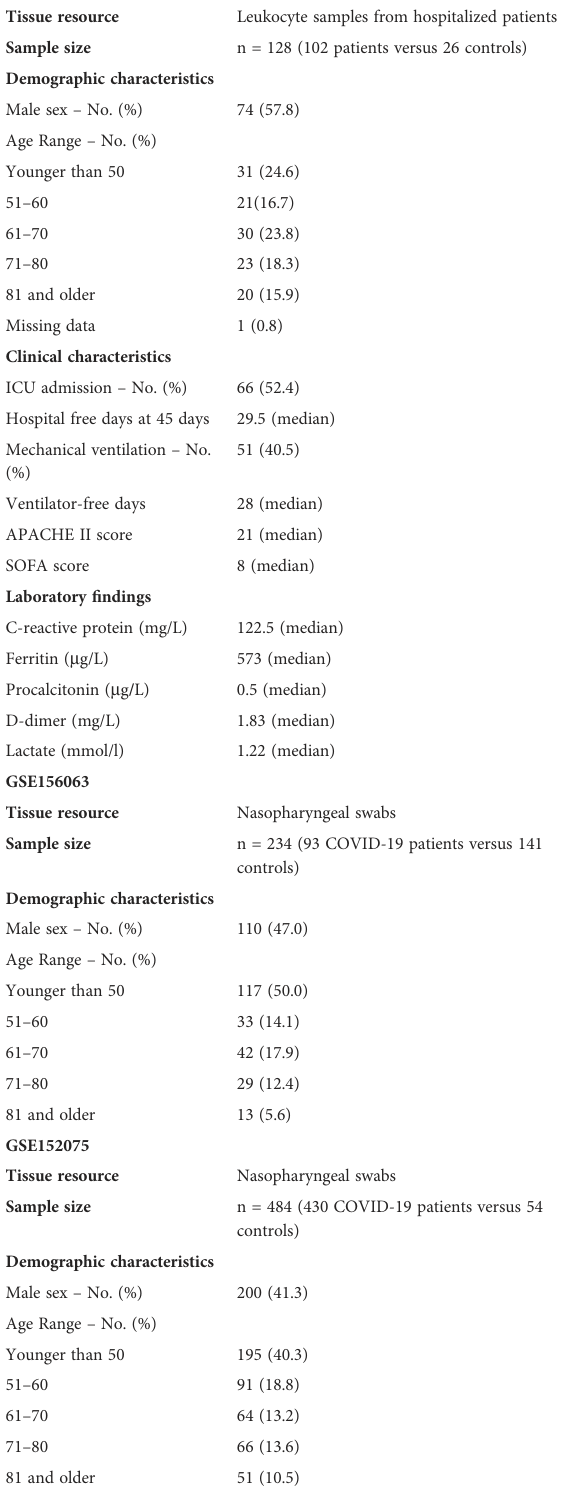
TABLE 1 A summary of the